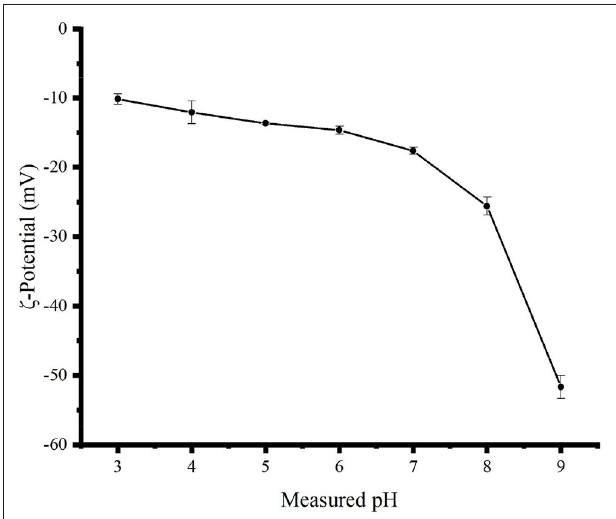
FIGURE 3 | Zeta potential curves of a 0.5 mg/ml TBs-E aqueous solution as a function of pH 3.0–9.0 adjusted using HCl and NaOH at an interval of 1.0 and a temperature of 25 ◦ C.